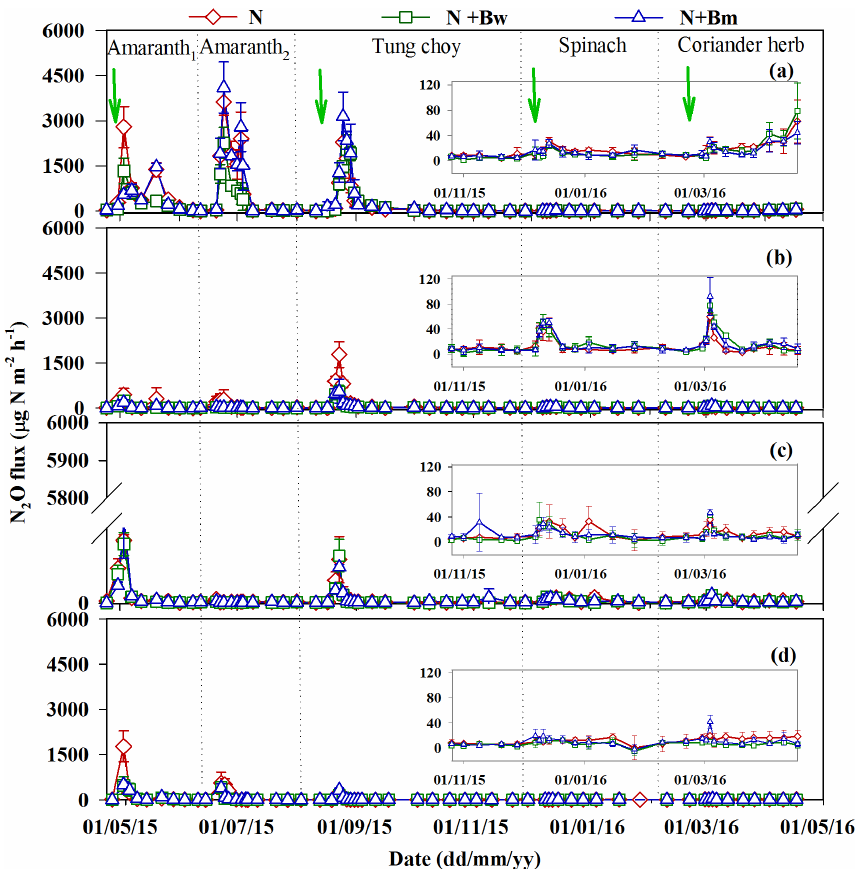
Figure 2. Temporal dynamics of soil N 2 O (µg Nm − 2 h − 1 ± SD, n = 3) fluxes under different treatments in Acrisol (a) , Anthrosol (b) , Cambisol (c) and Phaeozem (d) with five consecutive vegetable crops. The inserted panels describe the N 2 O fluxes during the last two cropping seasons. The solid arrows indicate fertilization. See Fig. 1 for treatment codes.